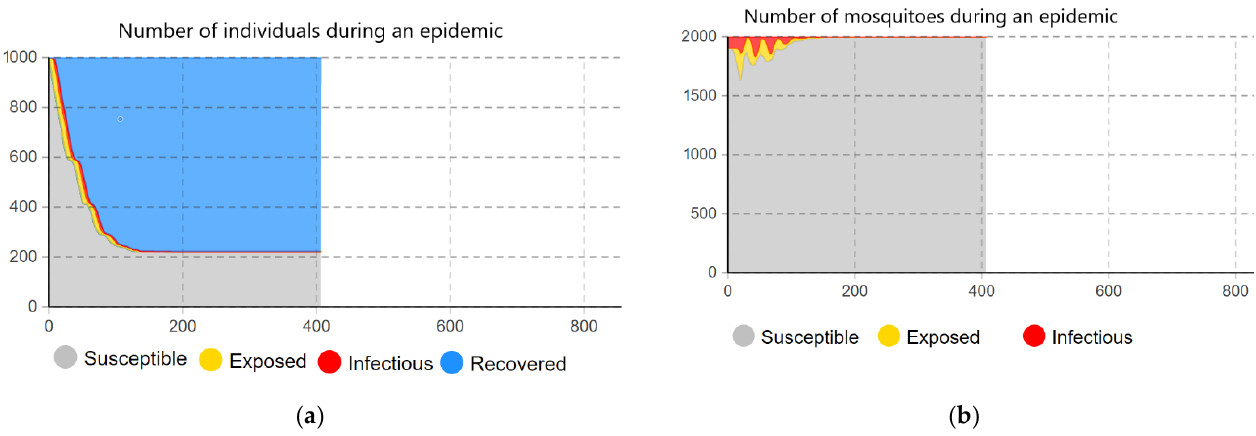
Figure 7. Evolution of epidemic in a large population: ( a ) total number of individuals per state; ( b ) total number of mosquitoes per state.